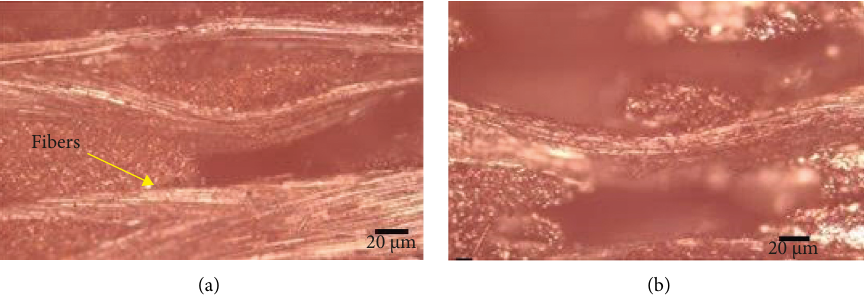
Figure 13: Optical microscope images of (a) partially burnt and (b) completely burnt composite samples (100X magnification).